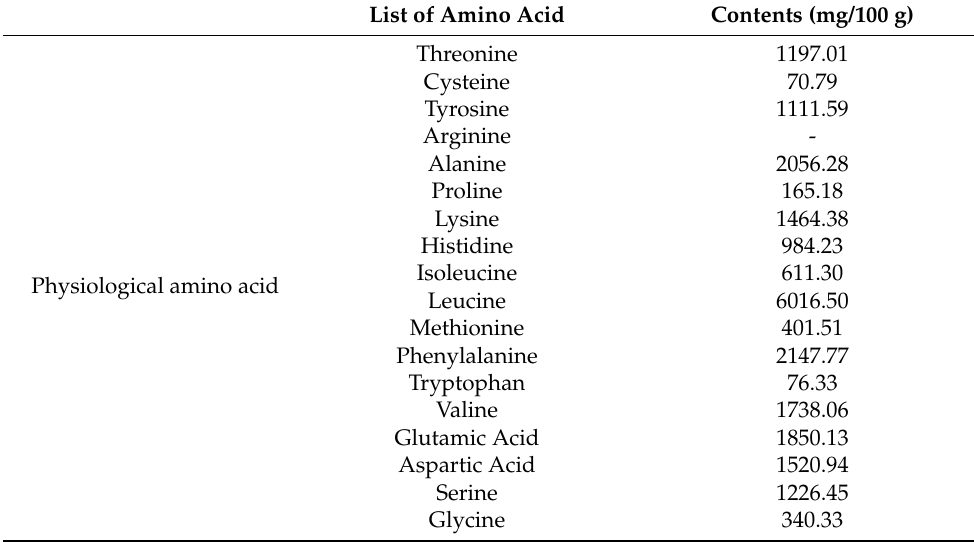
Table 1. Physiological amino acid compositions of